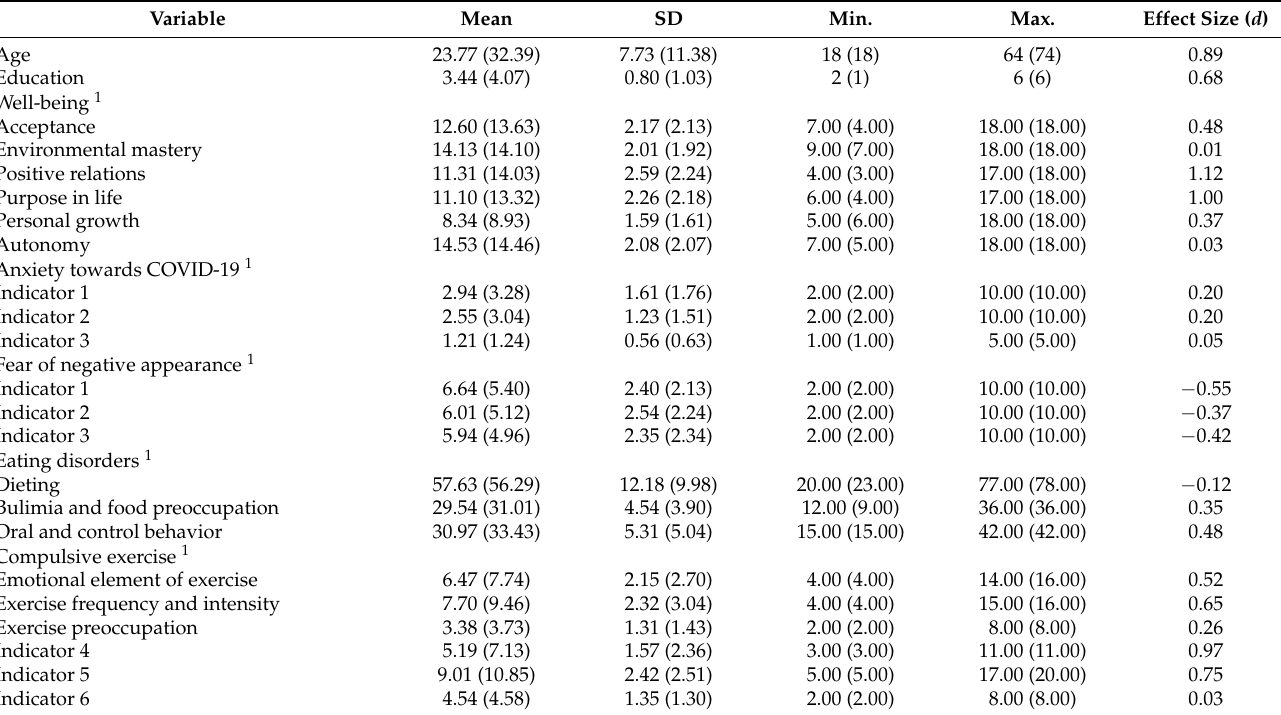
Table 1. Descriptive analysis of all